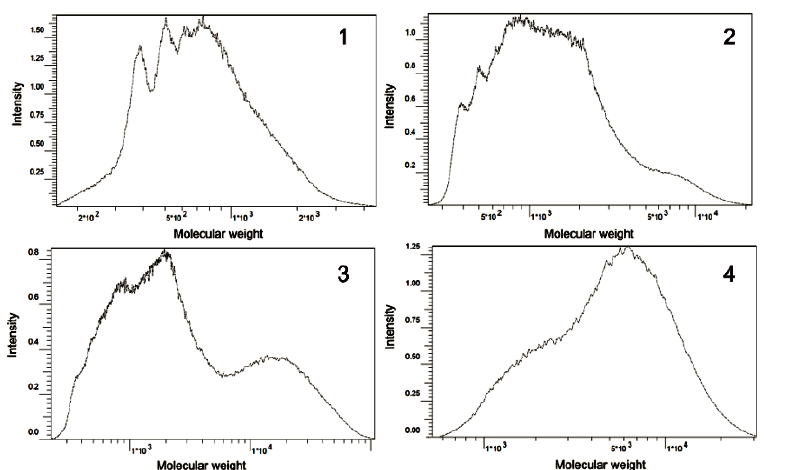
Figure 3. Molecular weight distribution of the cooligomers synthesized by: 1 – heterogeneous catalytic, 2 – homogeneous catalytic, 3 – thermal and 4 – initiated